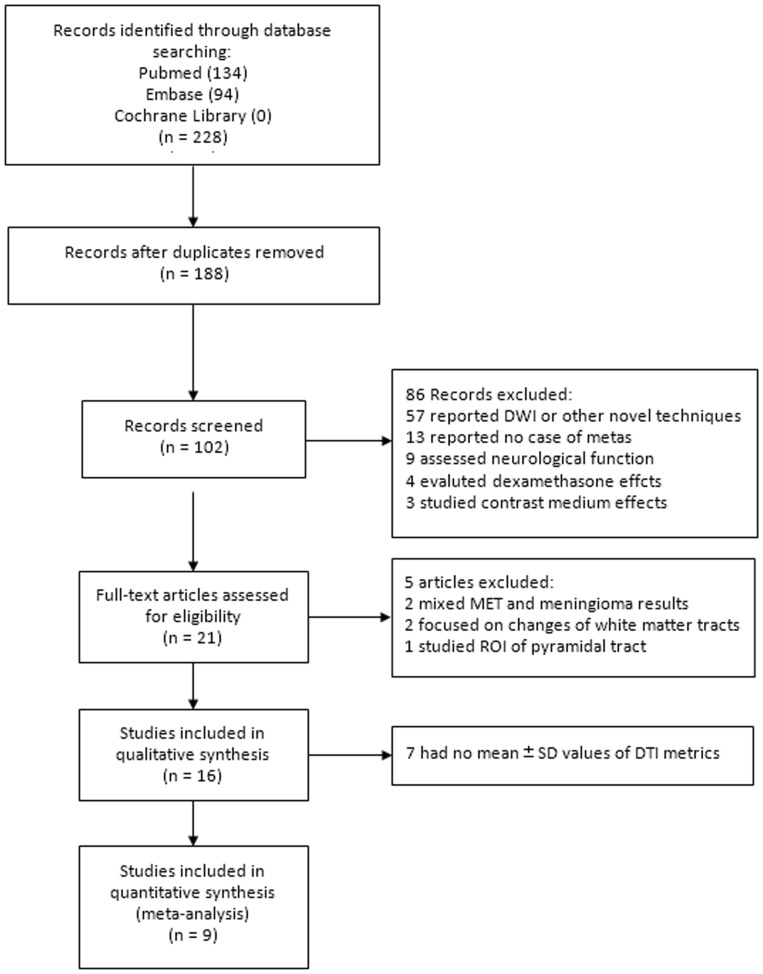
The flowchart shows the selection of eligible studies for meta-analysis.